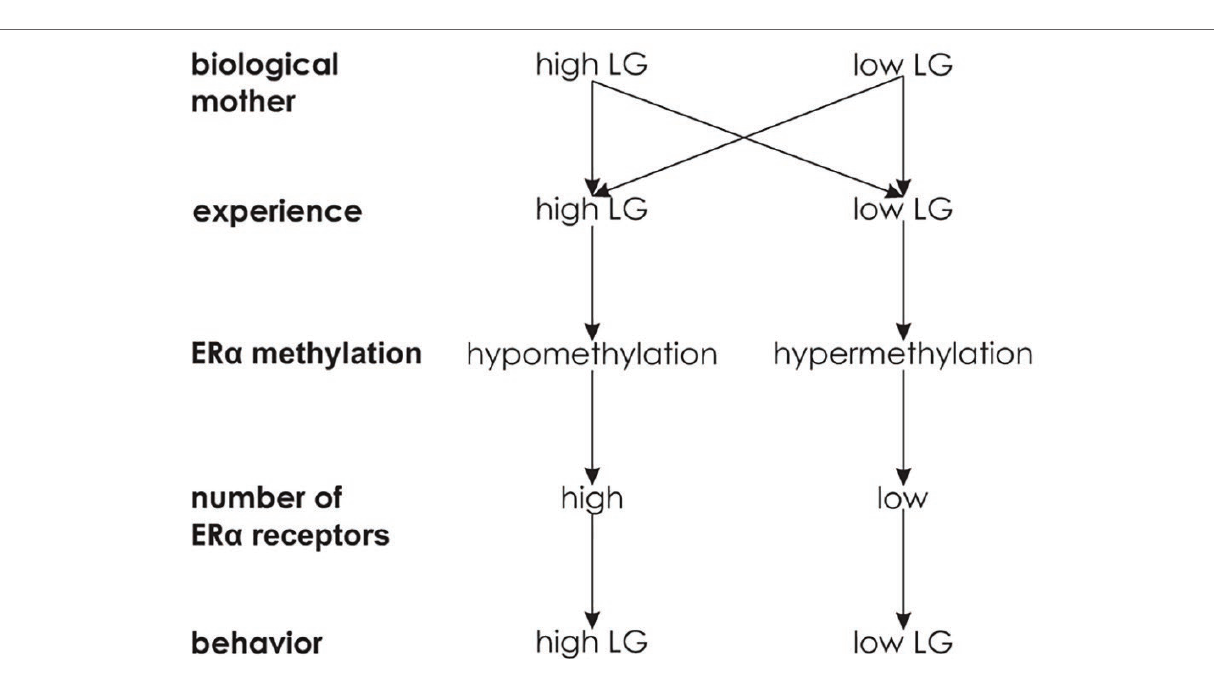
FIGURE 7 | Experience-dependent epigenetic inheritance. Independent of licking and grooming behavior (LG) of the biological mother, the experience of high LG is associated with a large number of ER α receptors and high LG behavior, while the experience of low LG behavior is associated with a low number of ER α receptors and low LG